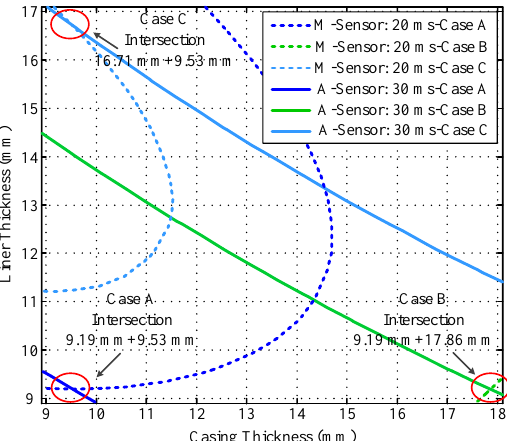
Figure 11. Intersection of the induced EMF curves using the auxiliary sensor.